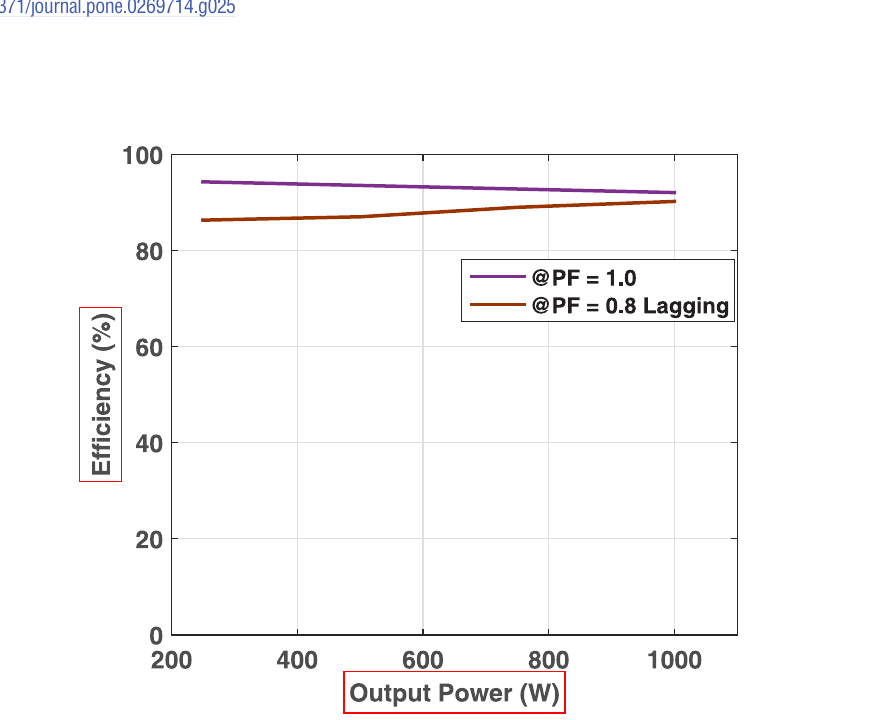
Fig 26. Experimental efficiency plot for various resistive and inductive loads.